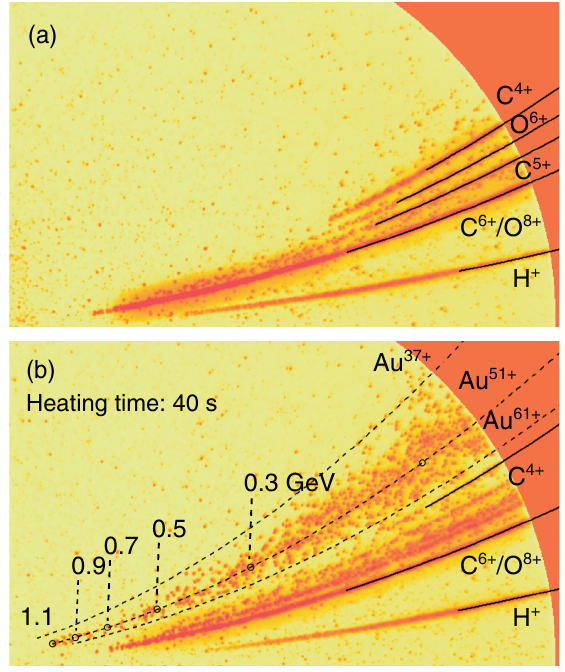
FIG. 2. Raw data measured with TPS from (a) a 20-nm diamondlike carbon target and (b) a double-layer Au target ( 60 μ m CNF þ 150 nm Au).